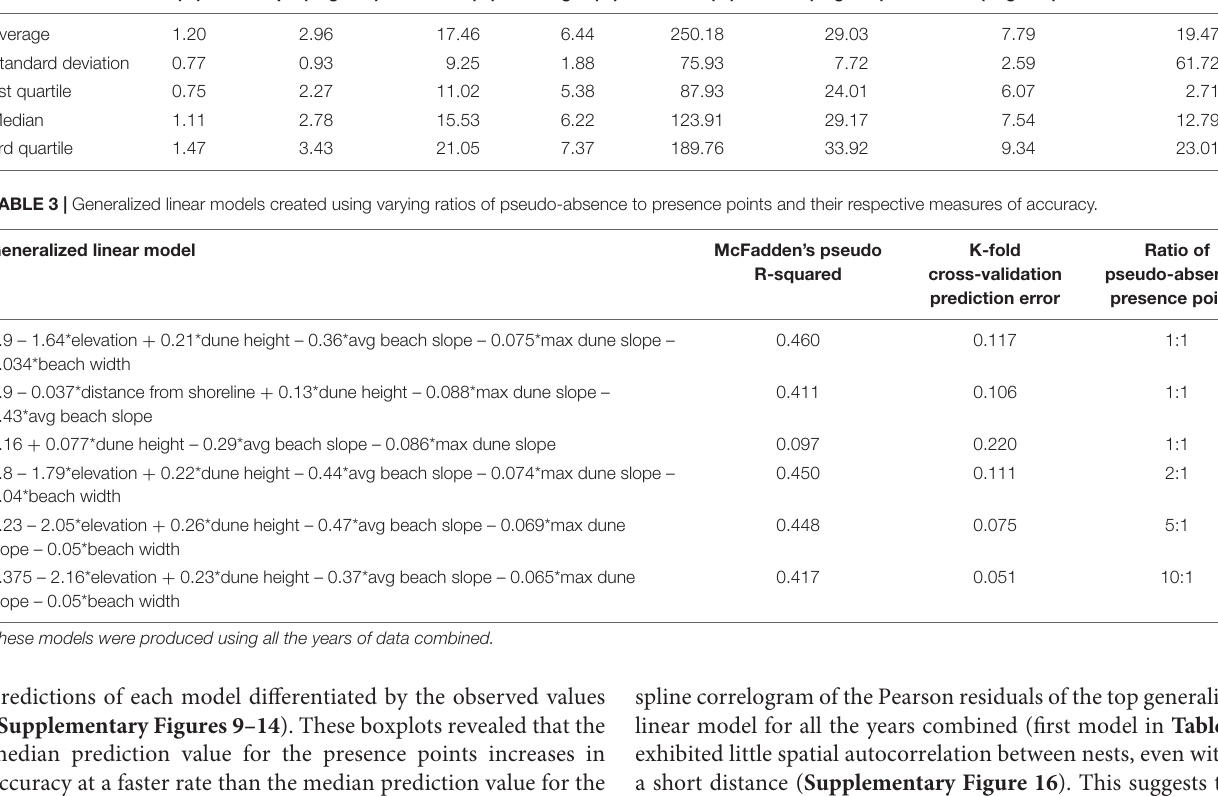
Elevation Avg beach (m) slope (degrees)